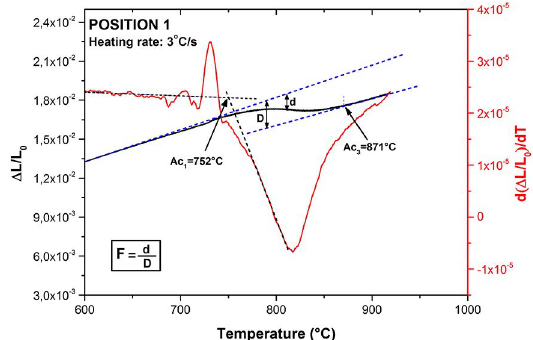
Figure 3. Dilatation curve of a dilatometry specimen for the heating rate of 3°C/s. F is the fraction of austenite determined by lever rule. Table 2. Austenitizing critical temperatures of the C-Mn steel. POSITION